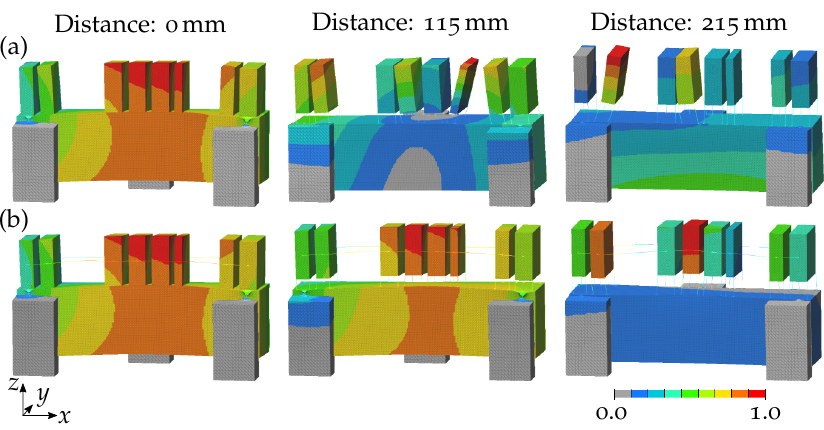
Figure 16. 5th mode shape of the box girder for individually positioned ( a ) and connected ( b ) magnets for distances between the magnets and the girder of 0 mm (magnets fixed to the upper girder surface), 115 mm, and 215 mm. The colours represent the normalised vibration